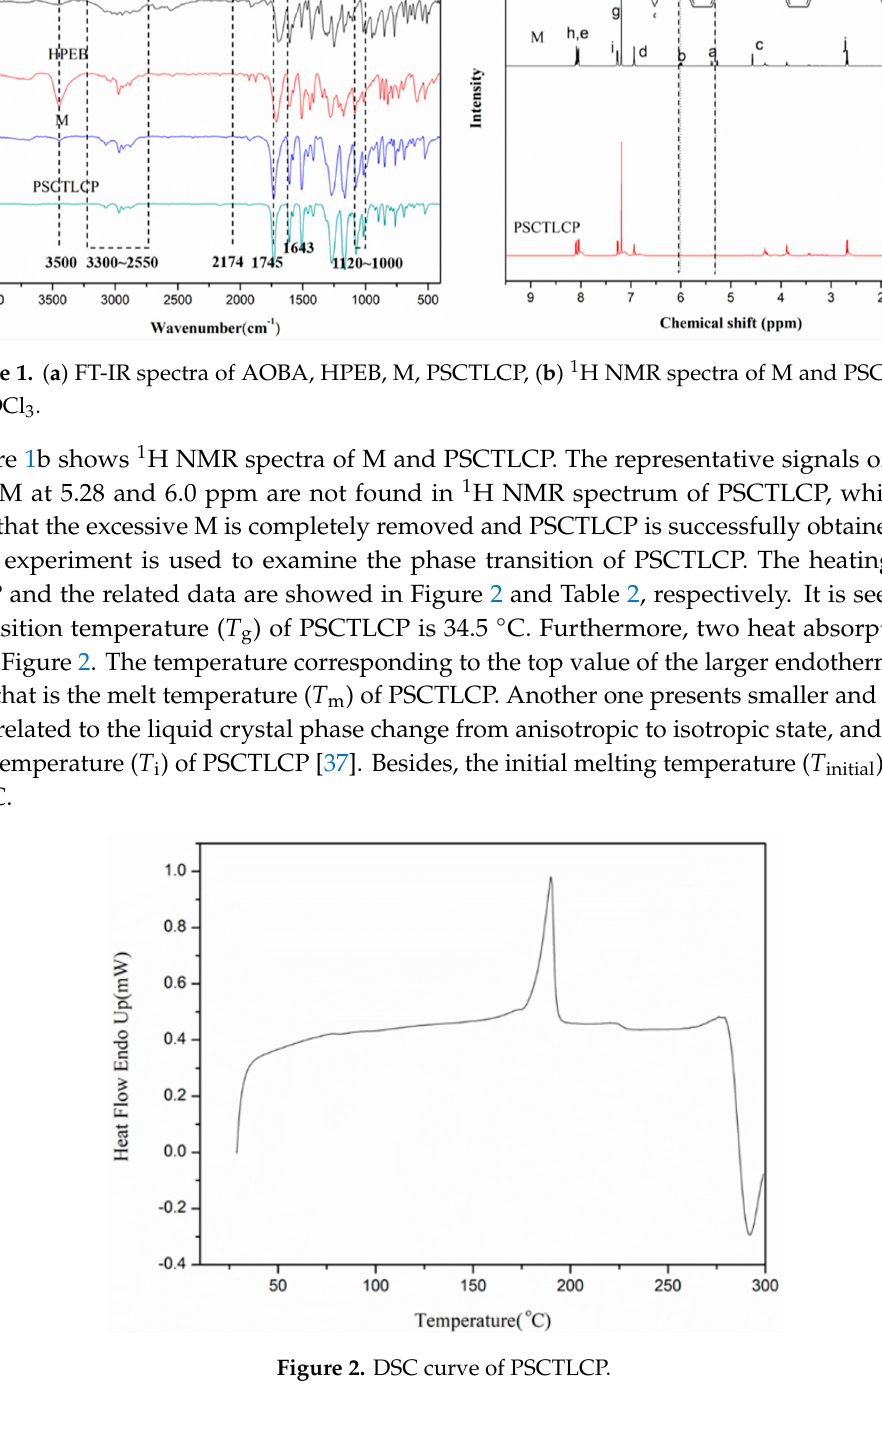
Figure 2. DSC curve of PSCTLCP.